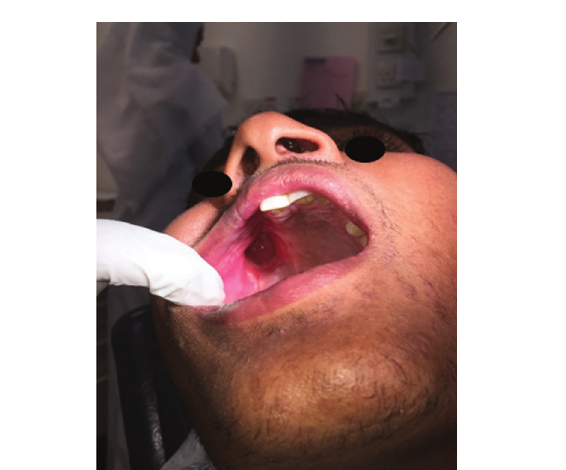
The oral cavity 2 weeks postoperatively.